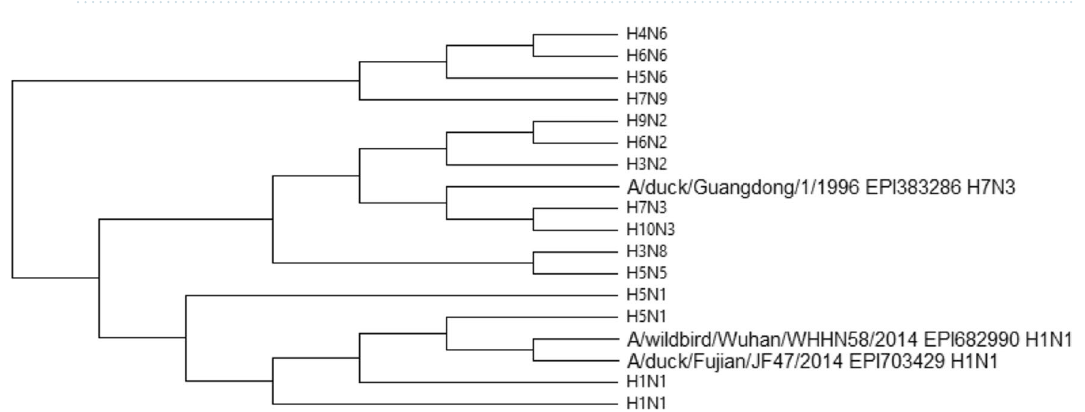
Figure 17. The phylogenetic tree of 113 Human rhinoviruses (HRV) and 3 HEV-C proteins constructed by our method (NJ).